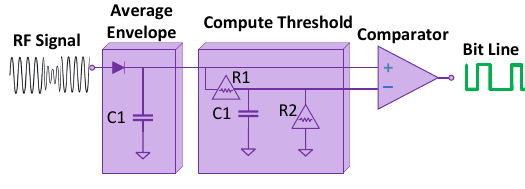
Figure 15. Signal detection in